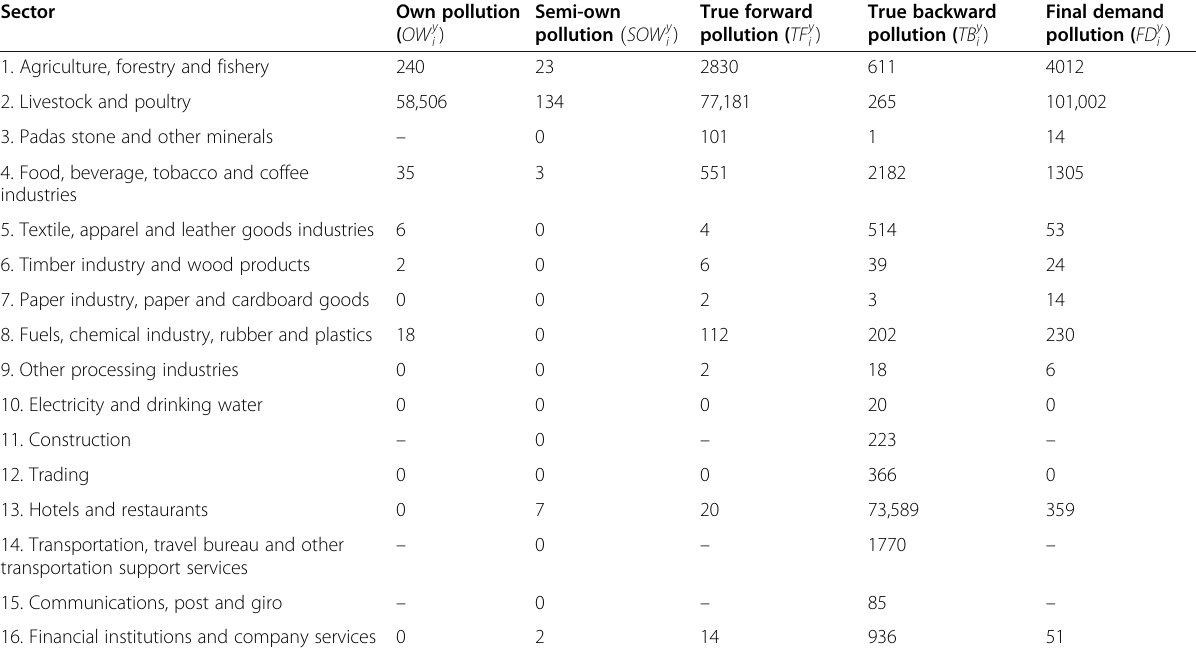
Table 4 Disaggregated sectoral pollution components with BOD loads (in tons) Sector